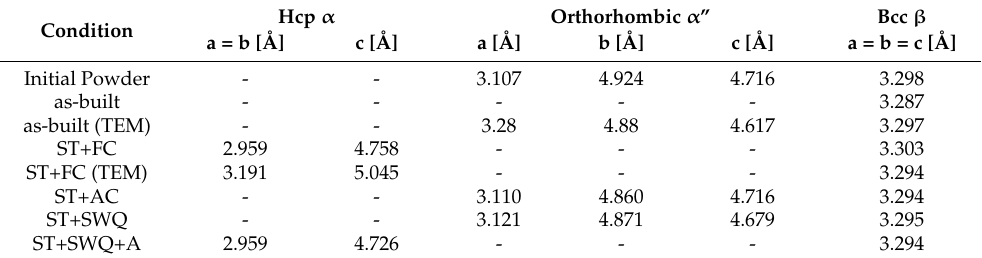
Table 2. Lattice parameters, determined by XRD, for hcp α , orthorhombic α ”, and bcc β of Ti2448 in the as-built, ST+FC, ST+AC, ST+SWQ, and ST+SWQ+A condition as well as the initial powder; lattice parameters determined by TEM (marked in